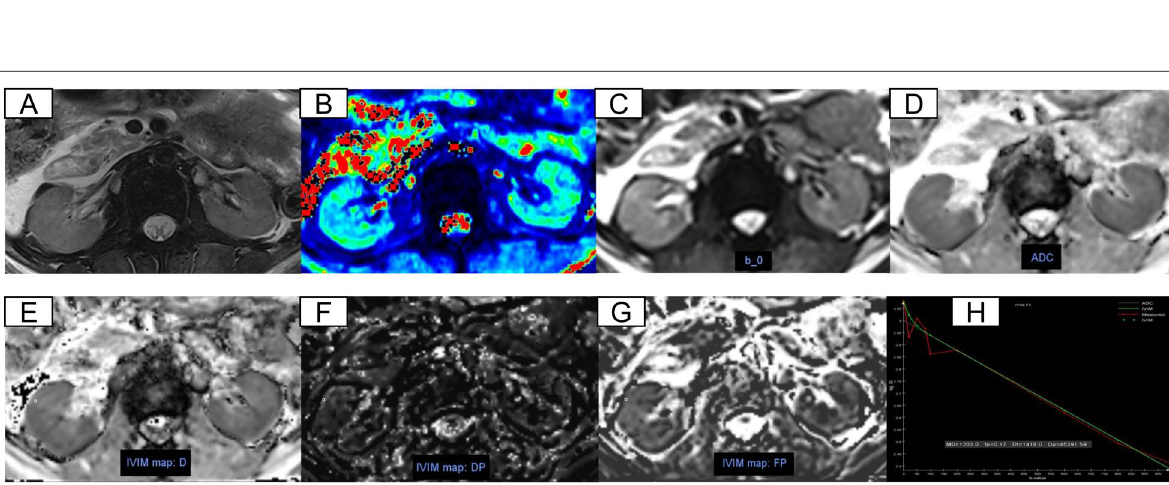
Fig. 4 Respective MRI images of CKD stage 4–5 (13 years old, female). A – H Axial T2-weighted images, T2* mapping, b0 map, ADC, D t , D p , f p , IVIM fit,